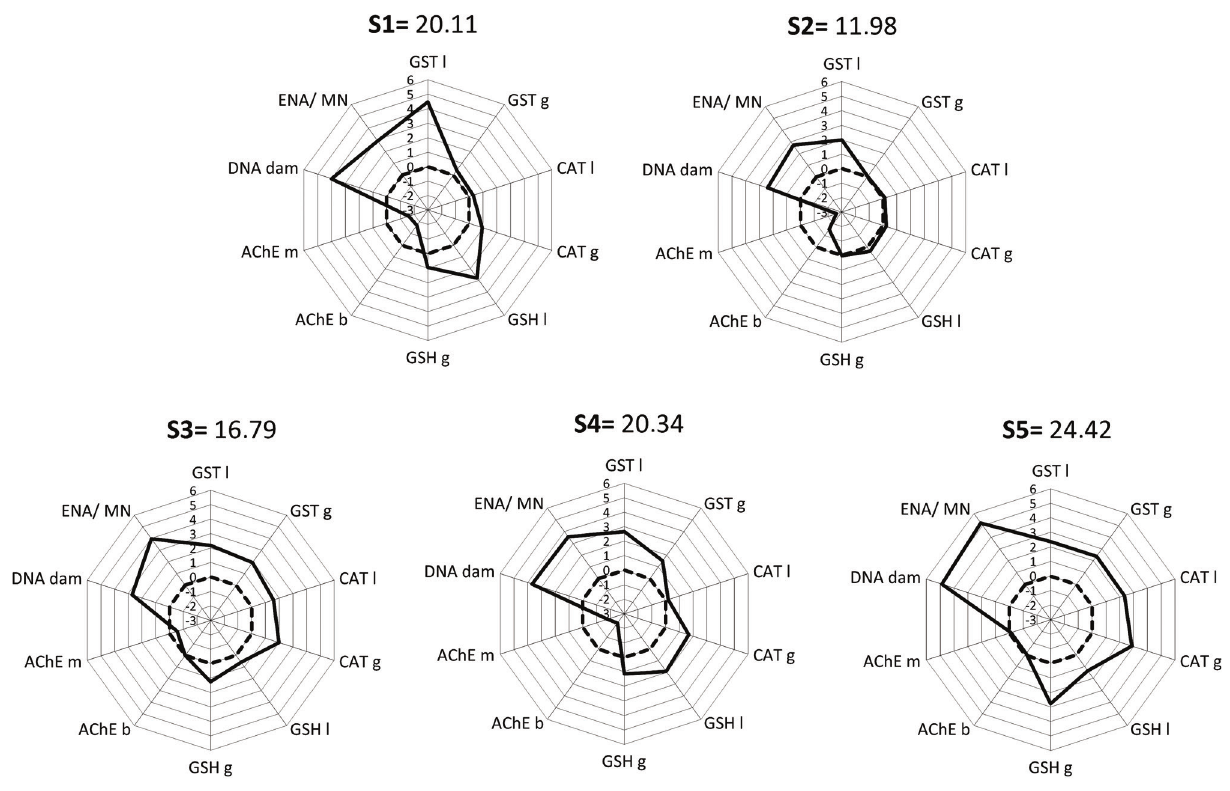
Fig. 7. Integrated biomarkers response index (IBR) values for each experimental site along Água das Araras stream (S1, S2, S3, S4, and S5) where in situ tests were performed. Biomarkers results are represented in relation to the reference site (0). The area above 0 reflects induction of the biomarker, and below 0 indicates reduction of the biomarker.